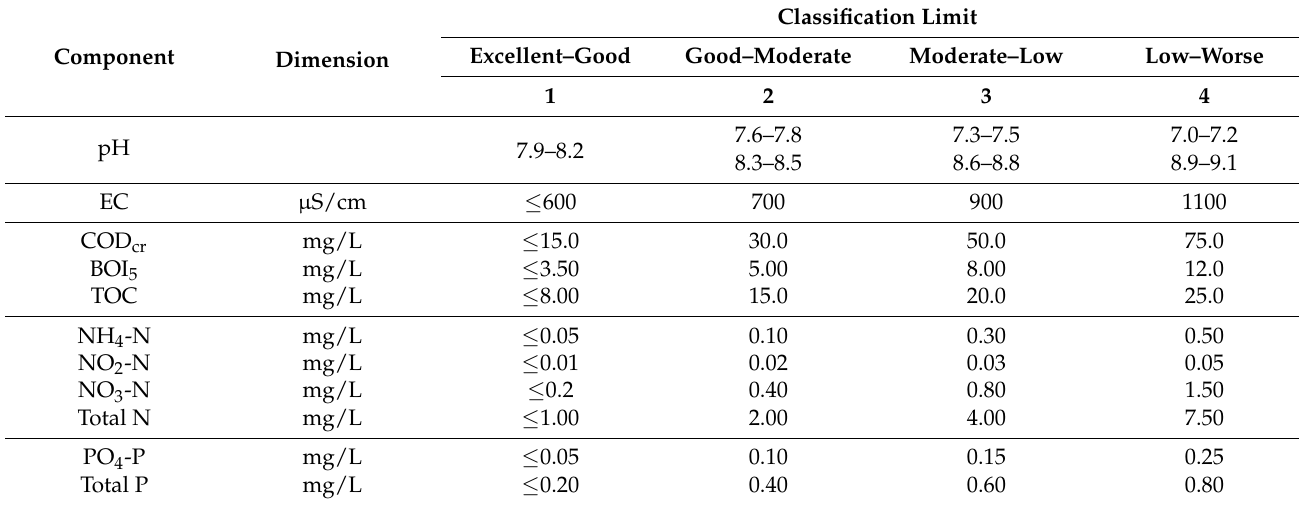
Table 2. Physico-chemical classification of heavily modified water